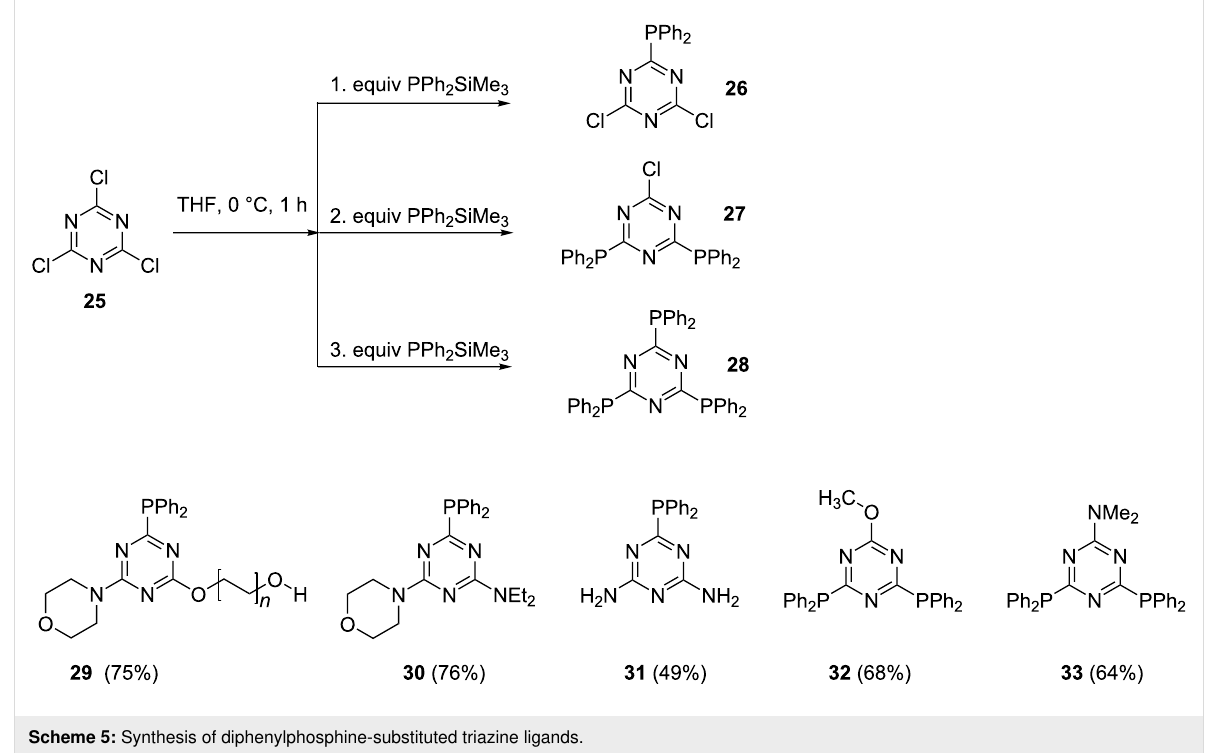
resulted in the corresponding bis- and